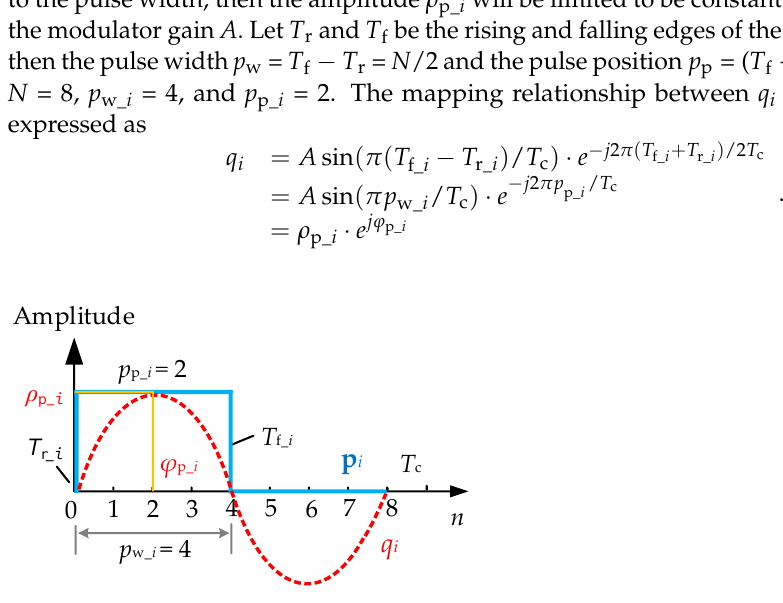
Figure 4. Pulse sequence p i and its corresponding q i .